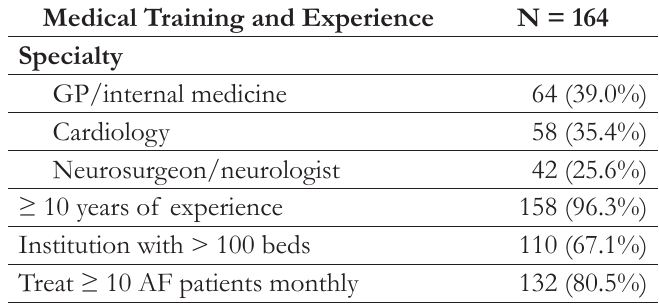
Table 4. Sample Characteristics: Physicians (n =